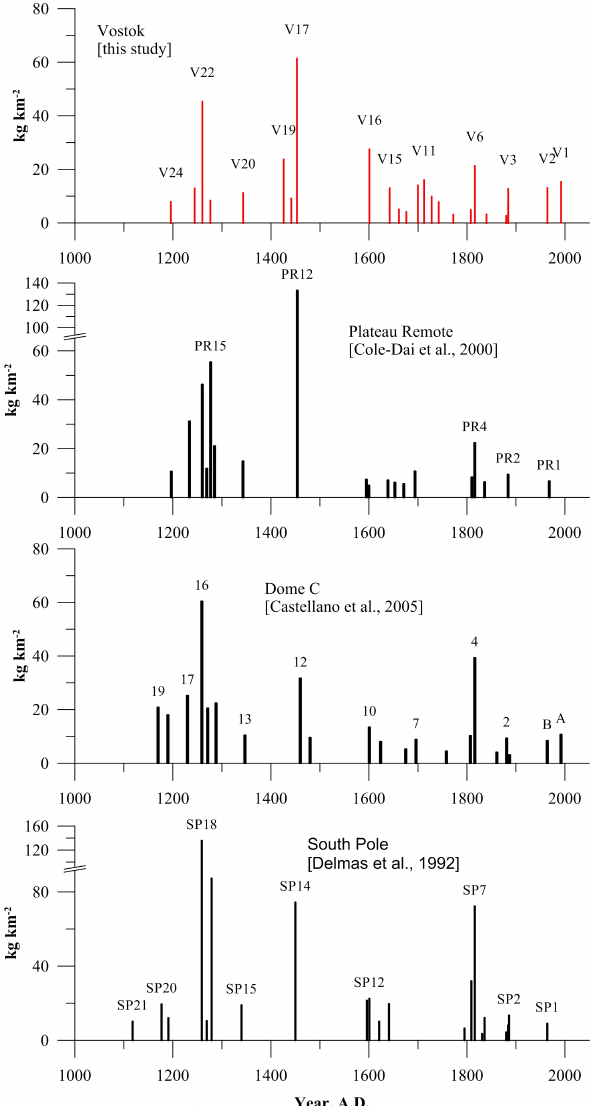
Fig. 3. Comparison of sulfate fluxes of volcanic eruptions recorded in four East Antarctic cores. Explanations are in the